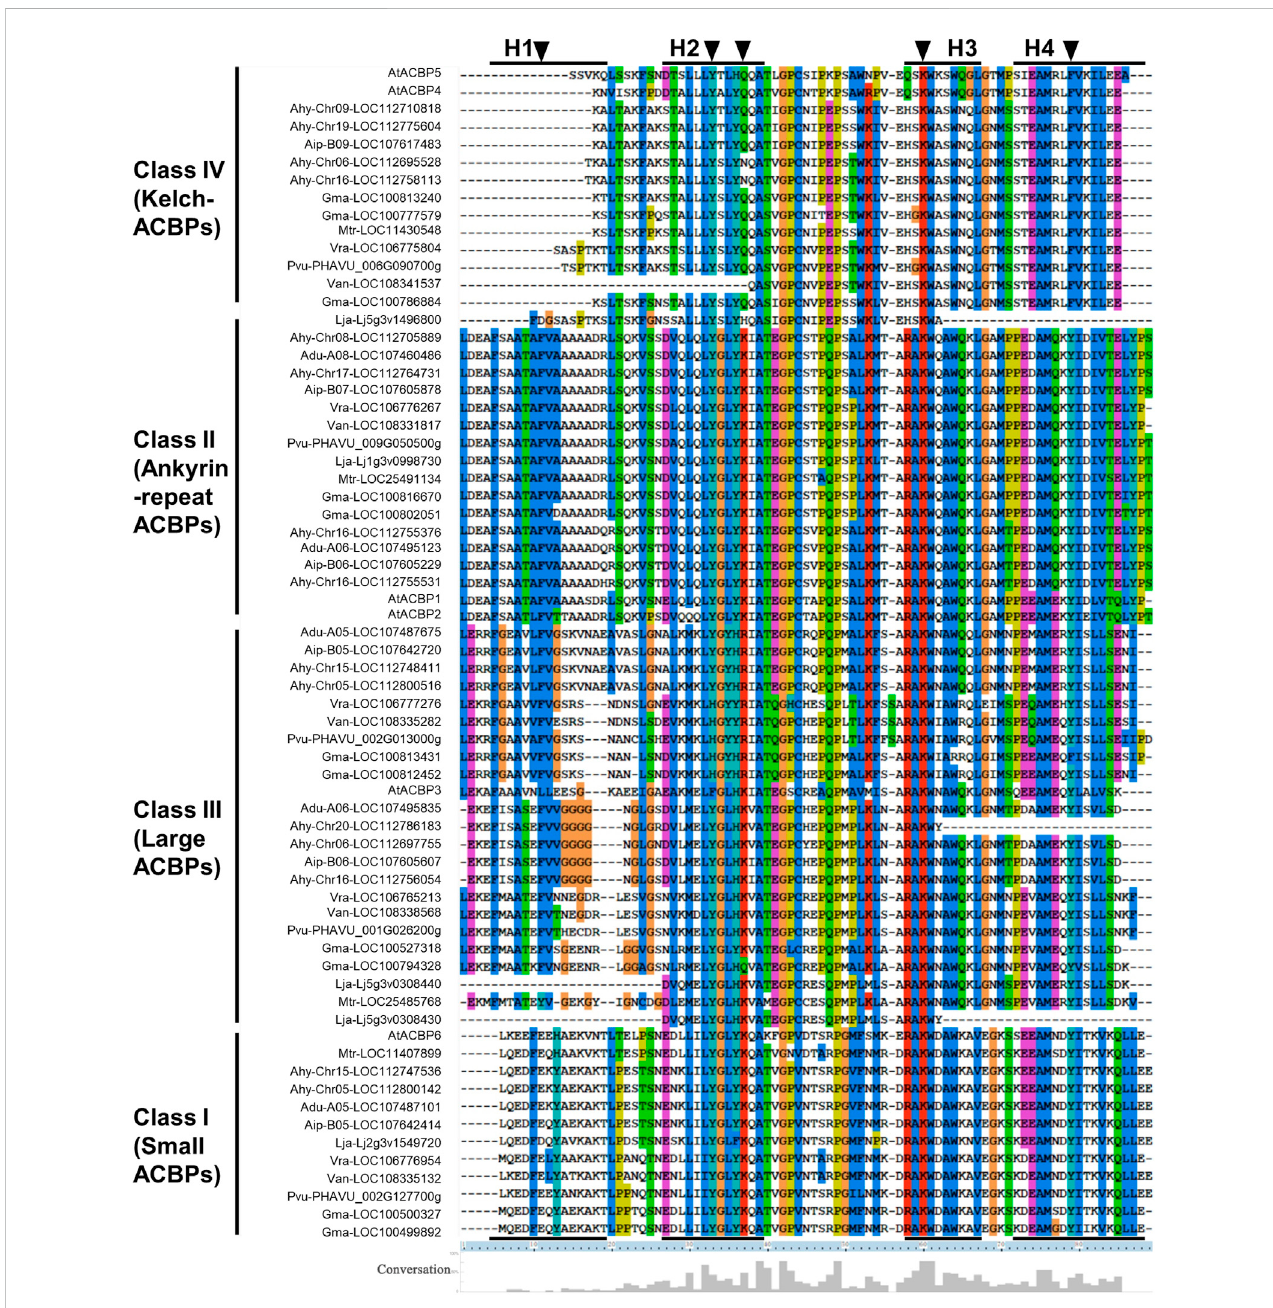
FIGURE 2 Sequence alignment of the ACB domains from the legume ACBPs. Conserved amino acids sites in these sequences are highlighted with different color. Arrowheads indicate the potential binding sites for acyl-CoA esters and H1-H4 indicate the positions of four putative alpha-helices. The percentage conservative of different sites is represented by the height of the histogram at the